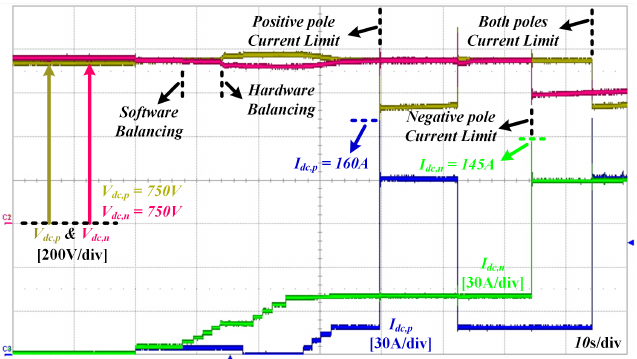
Figure 20. Experimental results of the entire